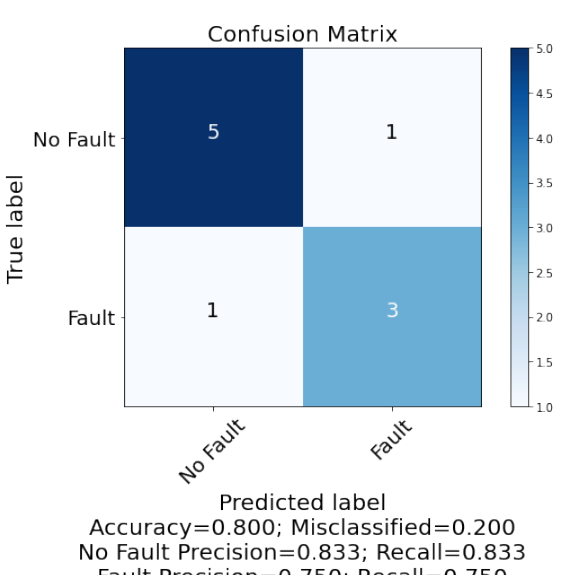
Figure 10. Confusion matrix and classification metrics for Fault / No Fault classification on the 20% held-out test set for the best performing classifier and dataset at LV